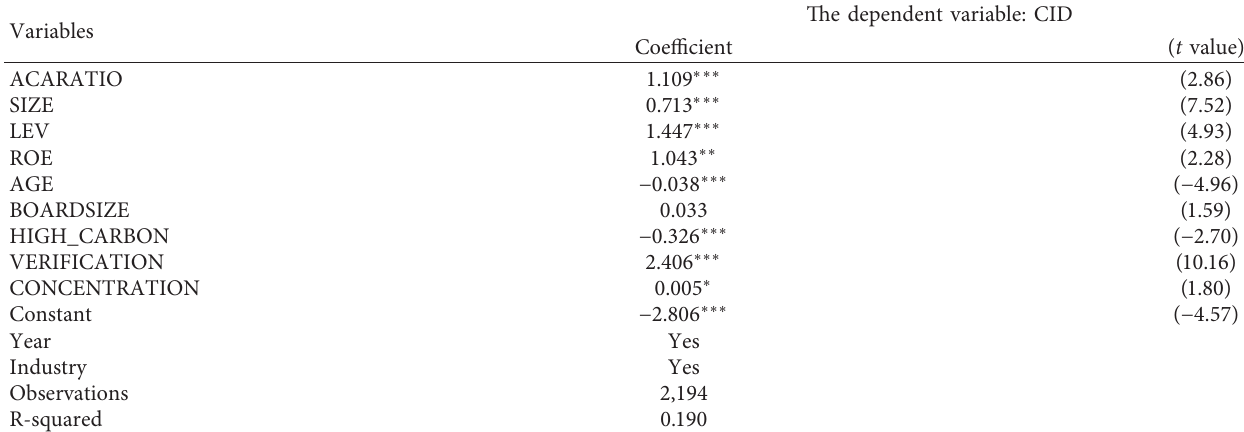
Table 5: Regression results of Hypothesis